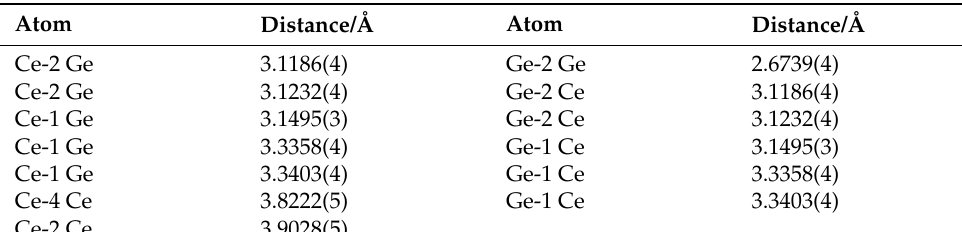
Table 6. Selected interatomic distances in CeGe.